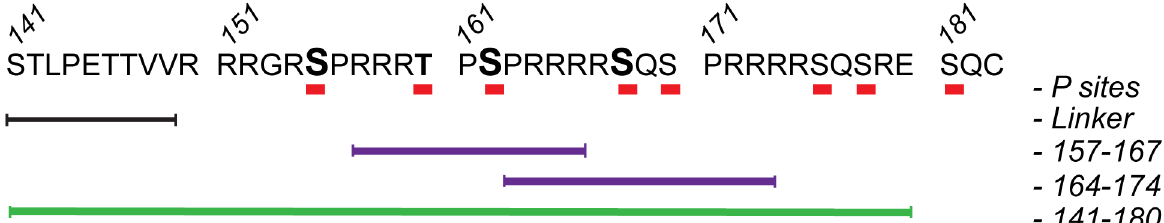
Fig 1. The C-terminal domain (CTD) of HBV core protein. Cp183 is comprised of an assembly domain (residues 1 – 149) that includes a nine-residue linker (underlined by the black line, 141 – 149) [83], and a 34-residue CTD. The CTD has seven phosphorylatable serines and one phosphorylatable threonine (red lines). Phosphorylation of serines 155, 162, and 170 (large letters) appears to play a critical role in RNA-packaging [11]. Arginine-rich segments have been associated with nuclear localization signals [21 – 23,27]; as an example, two peptides that conform to a classical bipartite NLS sequences (purple lines) have been demonstrated to compete with known NLS sequences [8]. Cp183 ’ s IBB segment has not been specifically identified but an IBB is ~40 amino acids including ~17 basic residues [28] and could thus incorporate most of the CTD as well as the linker region (green line); no other sequence in Cp183 has this wealth of basic